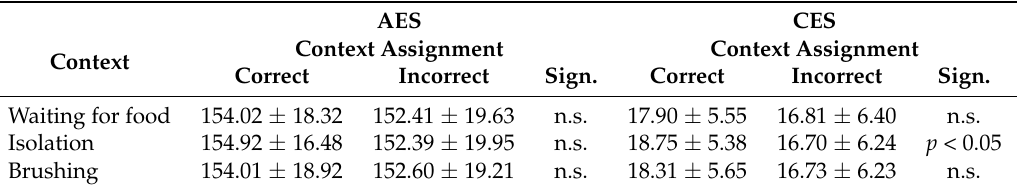
Table 4. Mean ( ± SD) of AES and CES of the participants depending on the correct or incorrect assignment of meows to each of the three